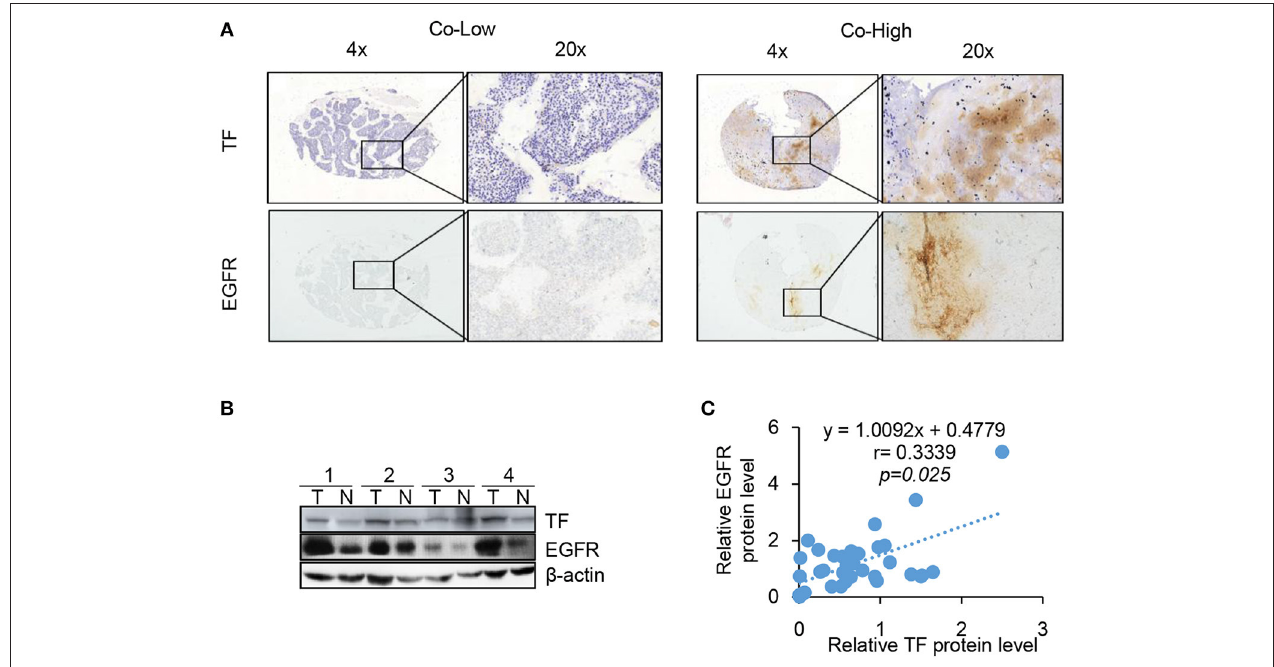
FIGURE 5 | TF protein expression is correlated with EGFR and poor HCC patient prognosis. TF and EGFR protein expressions in 144 HCC tissues were examined with IHC assay. (A) Representative images of positive and negative expression of both TF and EGFR were shown at 4 X and 20 X magnification. (B) Representative images of western blot analysis of TF and EGFR protein expression in the paired HCC tissues and adjacent normal tissues. (C) Spearman’s rank correlation test showed the correlation between TF and EGFR protein expressions by Western